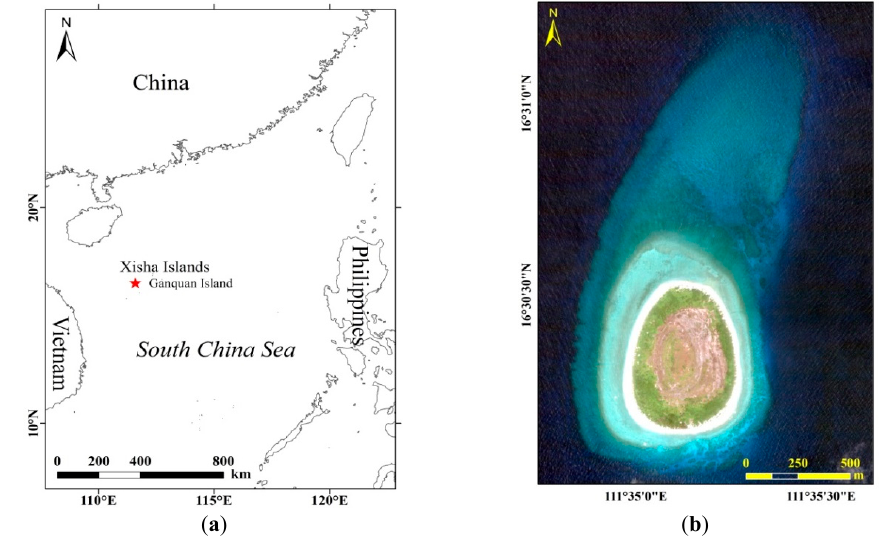
Figure 1. ( a ) The geographic location of Ganquan Island is marked with red five-star; ( b ) multispectral image of Ganquan